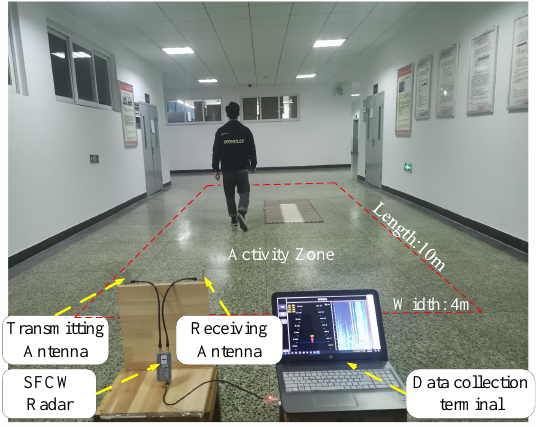
Figure 1. A photograph of the experimental environment.